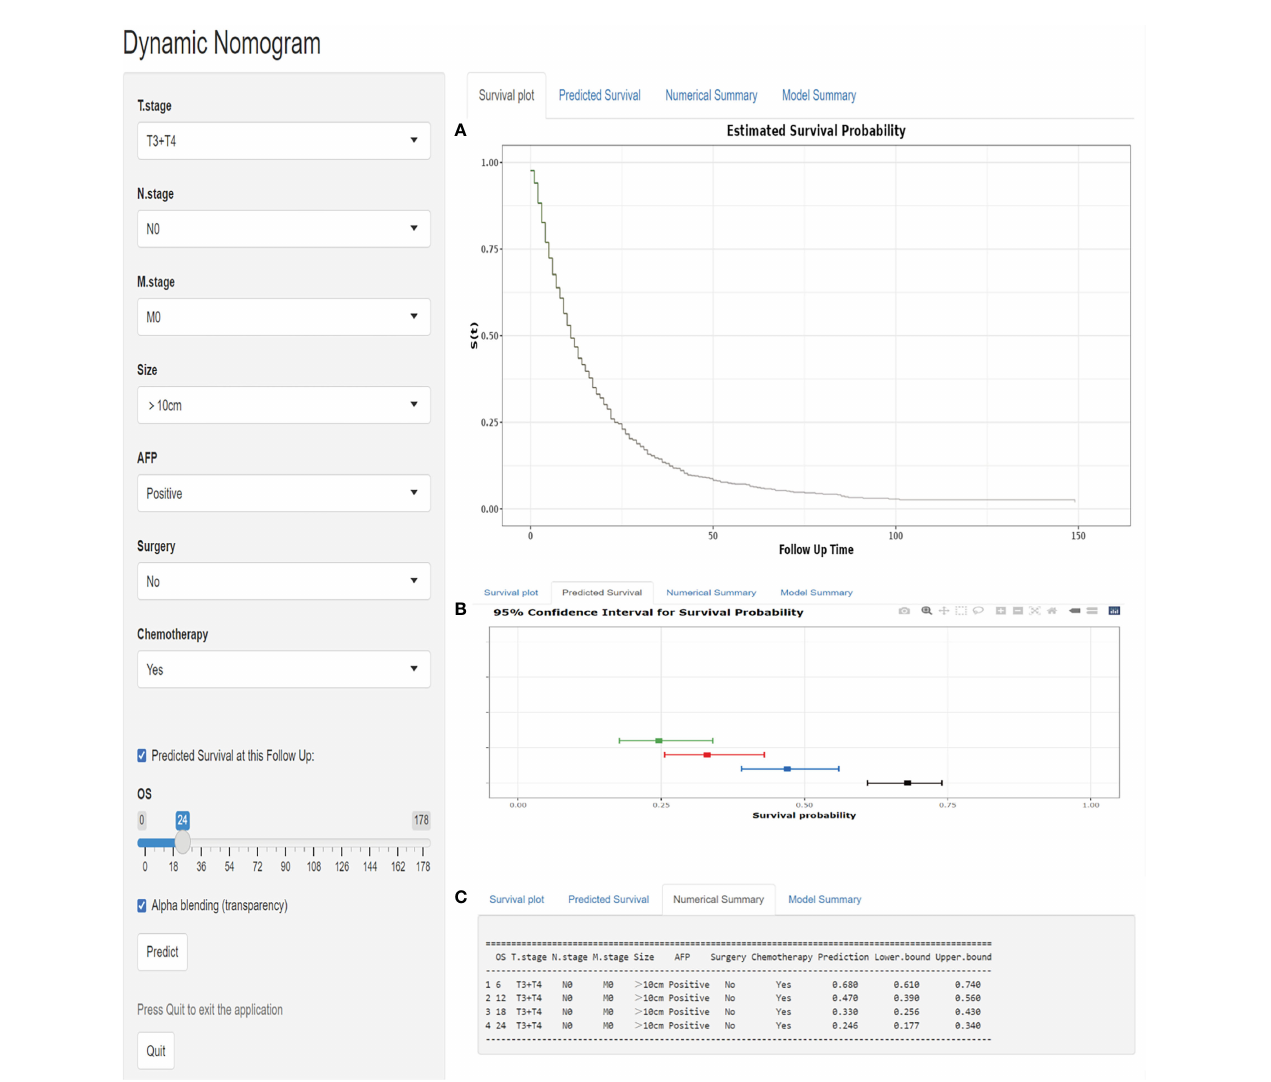
FIGURE 7 A web-based nomogram for predicting overall survival after EBRT with HCC patients. (A) The curve of estimated survival probability for those patients over time. (B) The 95% CI of the 6-, 12-, 18-, and 24- month survival probabilities for those patients. (C) The numerical summary of the 6-, 12-, 18-, and 24- month survival probabilities for those